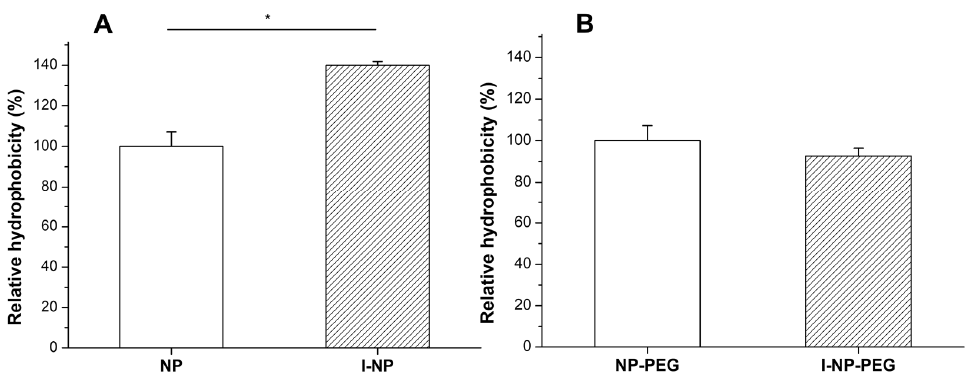
Figure 2. Surface hydrophobicity of ( A ) empty and insulin-loaded bare nanoparticles (NP and I-